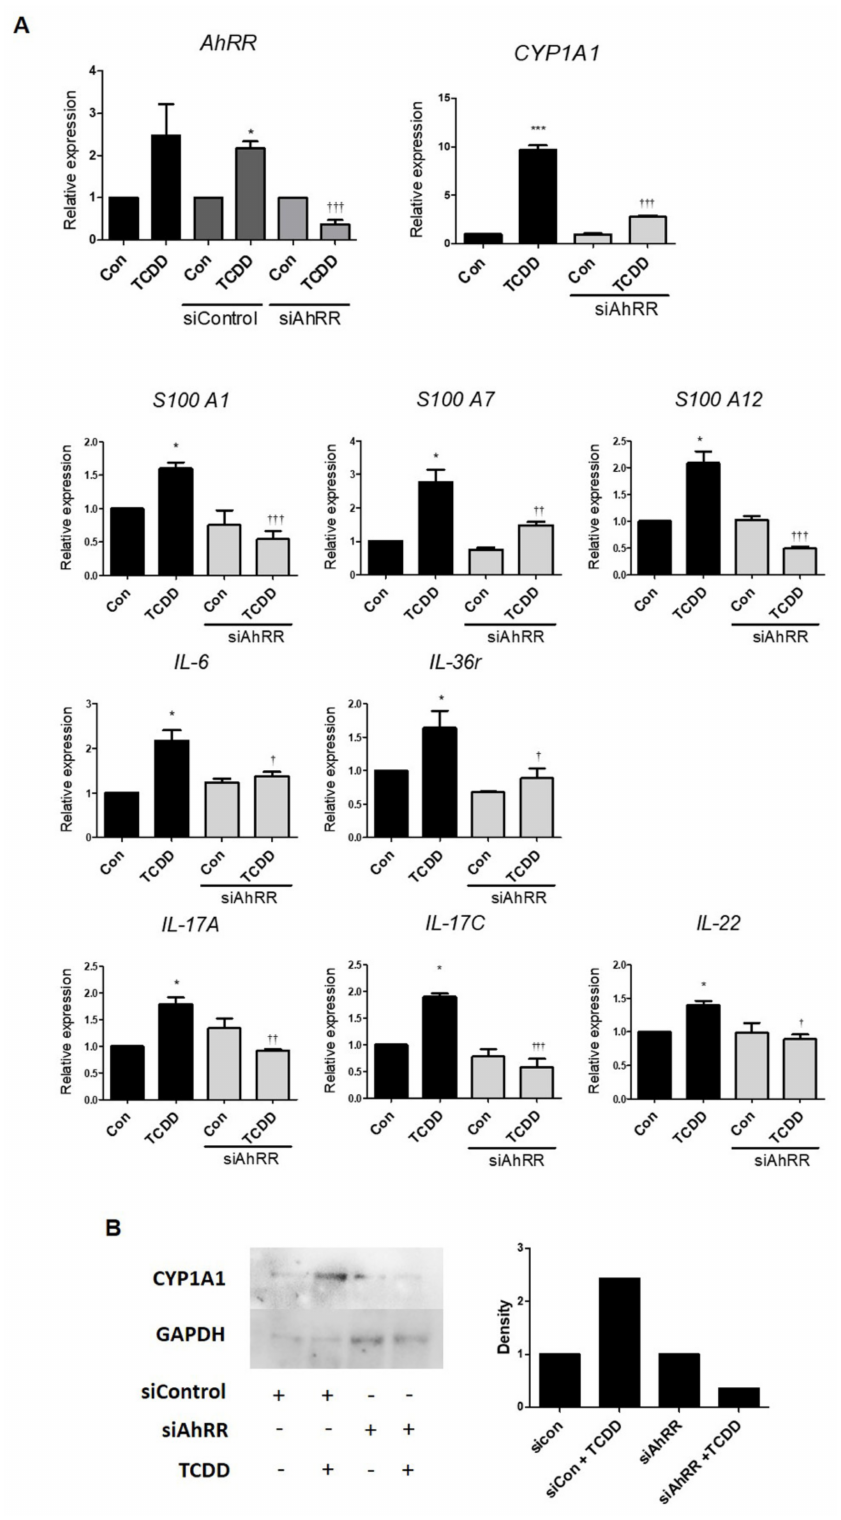
Figure 5. Effect of AhRR silencing on pro-inflammatory cytokines in HaCaT cells. HaCaT cells were transfected with siControl (10 nM) and siAhRR (50 nM) for 4 h and treated with TCDD (500 nM) for 24 h, and mRNA expression levels were examined by qPCR ( A ) and Western blot ( B ) Values are means ± SEM. All experiments were performed in at least three independent experiments. * p < 0.05 vs. control, *** p < 0.001 vs. control, † p < 0.05 vs. TCDD, †† p < 0.01 vs. TCDD, ††† p < 0.001 vs.